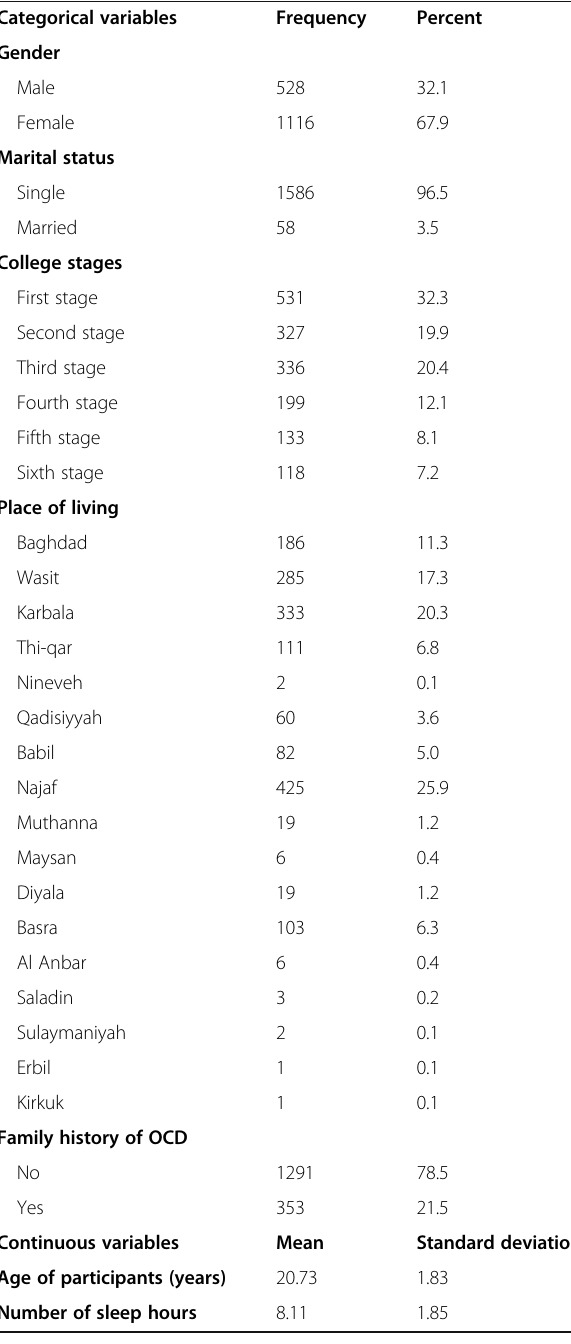
Table 1 Frequency distribution of socio-demographic features of the study